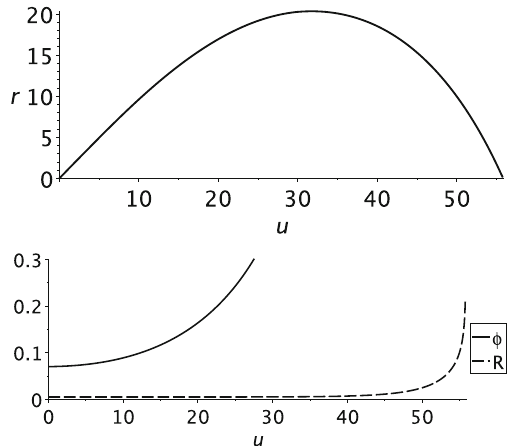
Fig. 1 The extra space metric function r ( u ) , the Ricci scalar R ( u ) of 6D space and the scalar field φ( u ) for f ( R ) = aR 2 + bR + c and V (φ) = ( m 2 / 2 )φ 2 (units m D = 1). The parameter values are m = 0 . 1 , b = 1 , a = − 100 , c = − 0 . 0021. Additional conditions are: φ 0 = 0 . 07 , H = 0 . The value of R ( 0 ) follows from Eq.(23). Here R ( 0 ) (cid:10) 0 .